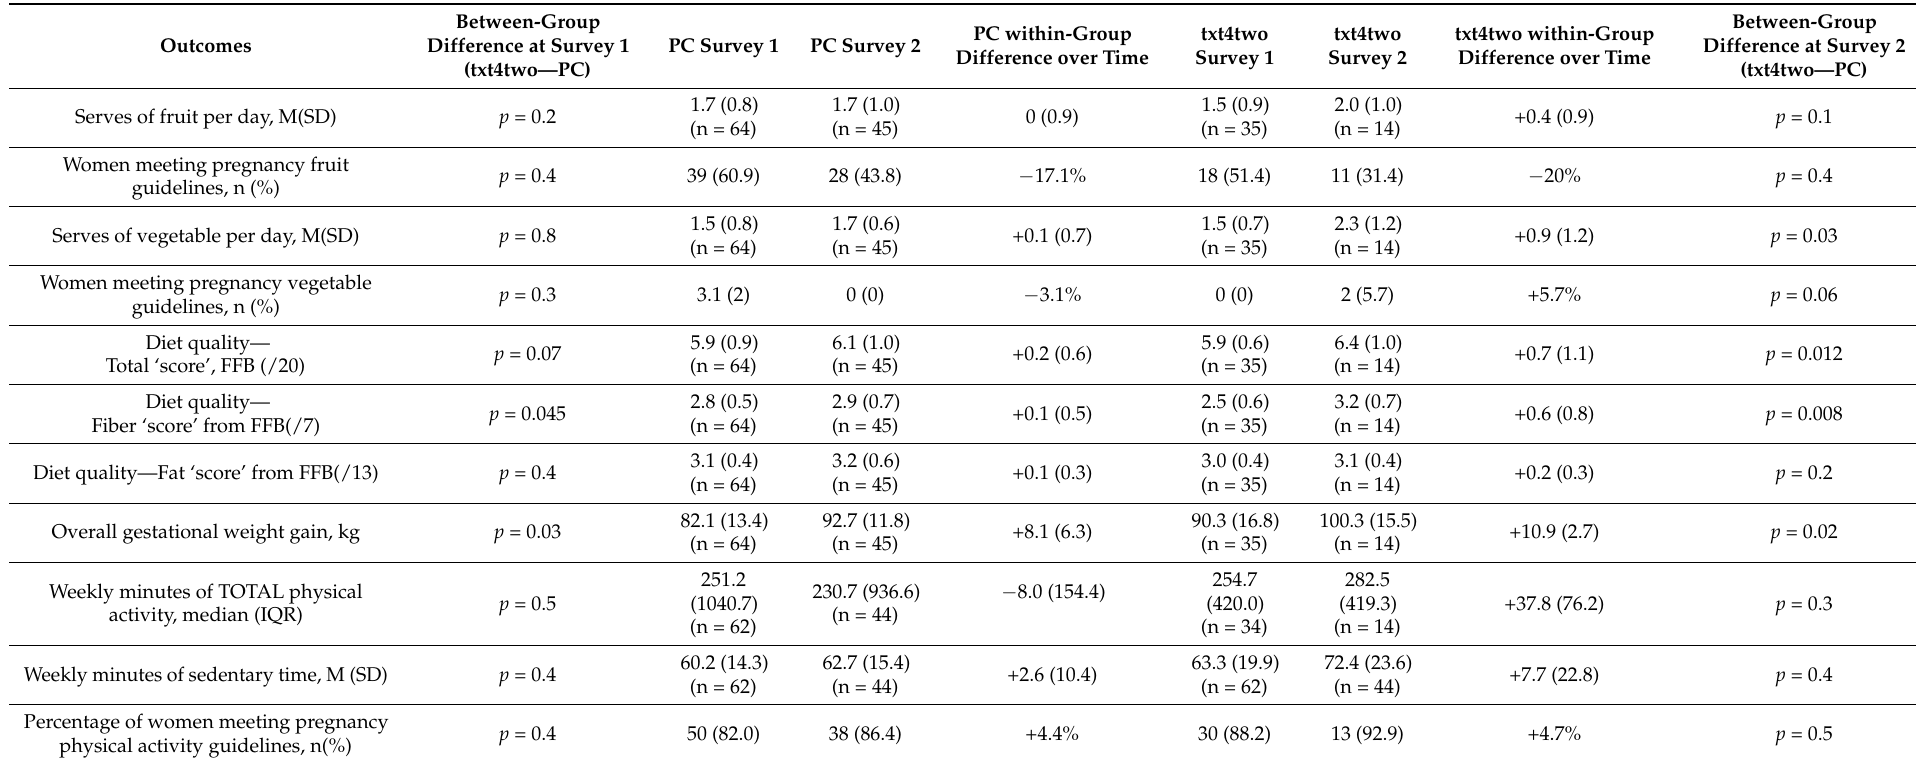
Table 2. Behavioral and weight outcomes at Survey 1 and Survey 2 for the Prospective Control (PC) and txt4two cohorts, changes within-groups over time and differences between groups at Survey 1 and Survey